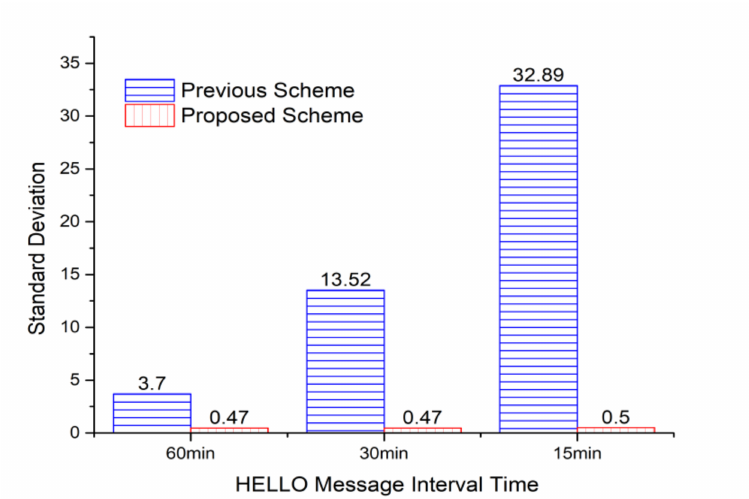
Figure 10. Standard deviations of the numbers of relay nodes selected by the middle cluster header in Figure 9.